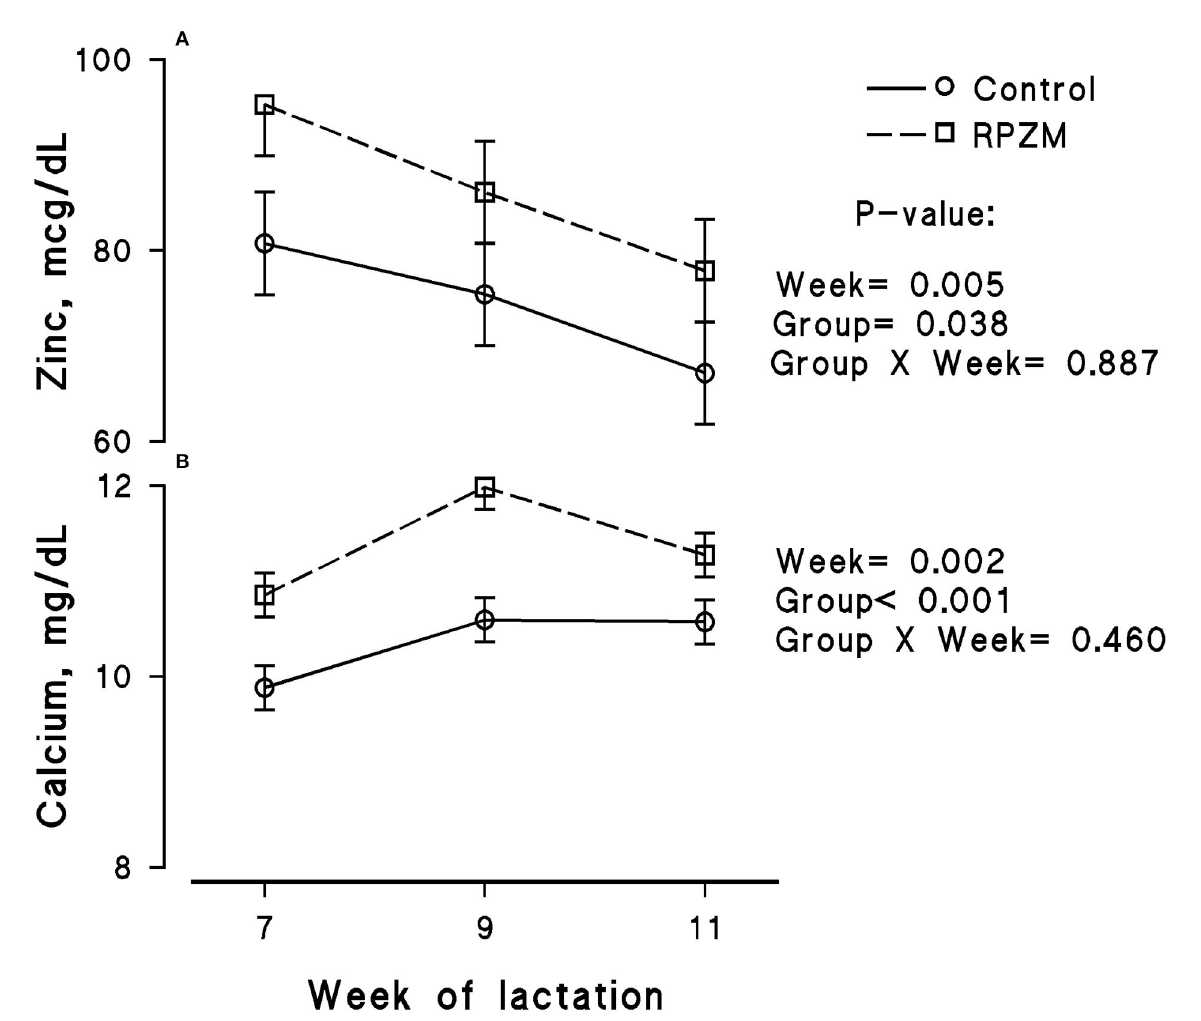
FIGURE5 Blood serum concentration of zinc (A) and calcium (B) of high-producing Holstein cows, through lactation weeks 6–11, supplemented without (control) or with rumen-protected zinc–methionine complex (RPZM) during long-term environmental heat stress. Values are means ± standard error of